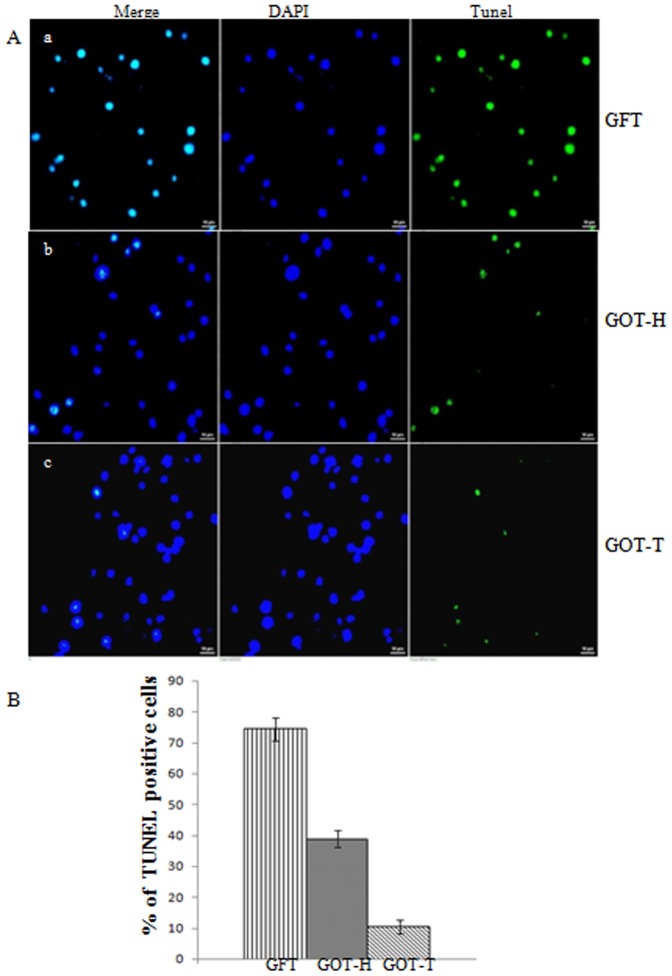
Immuno-fluorescence detection of apoptosis by TUNEL assay.The representative confocal images of isolated granulosa cells (Fig. 6A) demonstrate higher proportion of TUNEL positive cells (green) in the GFT ovary (Fig. 6A-a) as compared to the GOT-H (Fig. 6A-b) and GOT-T ovaries (Fig. 6A-c) that show little or no TUNEL positive cells. Each image is one representative of 3 replicates from 3 independent pools of cells, each representing 6-8 rats of the respective groups. The histogram (Fig. 6B) shows the mean percentage ±SEM of apoptotic cells counted in 9 microscopic fields at ×100. There are 3 randomly selected fields per slide, and each slide is represented by independent pool of cells. GFT vs. GOT-H: P<0.0001; GFT vs. GOT-T: P<0.0001.